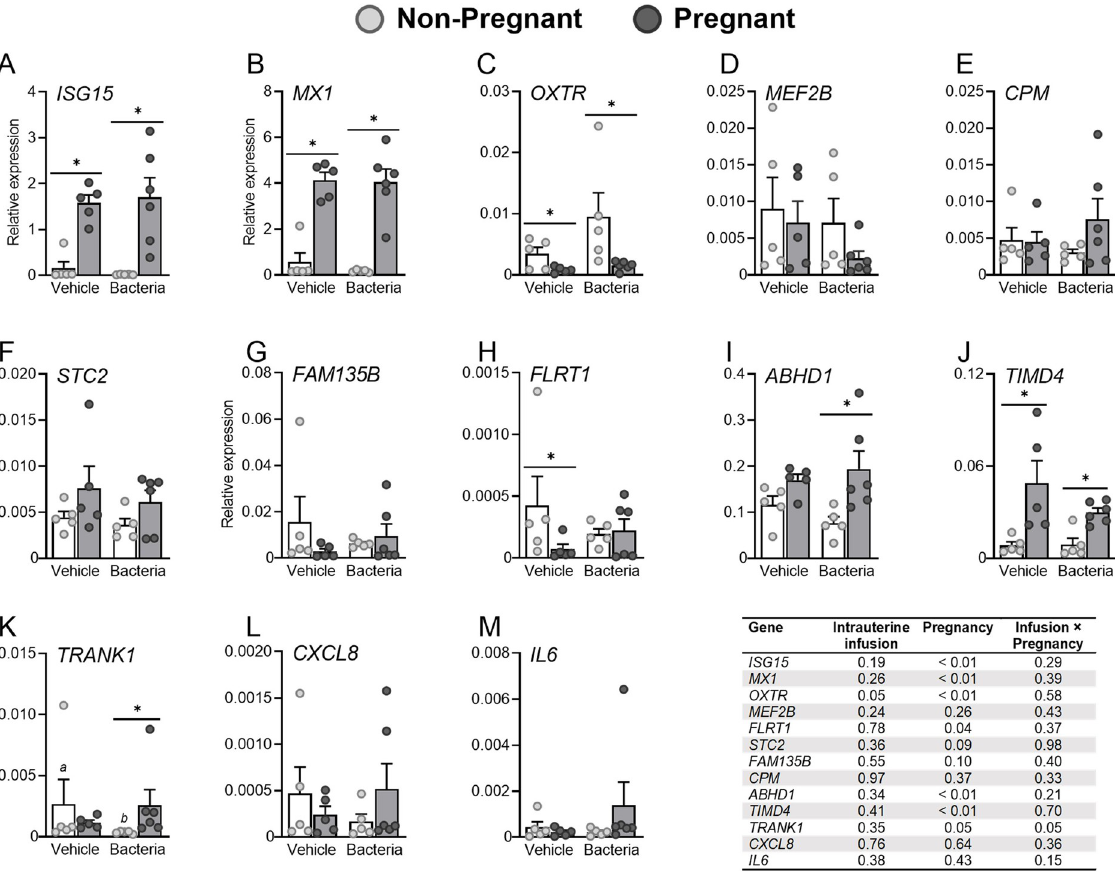
Fig 6. Effect of pregnancy and intrauterine infusion of pathogenic bacteria on the expression of endometrial genes identified by transcriptome analysis.